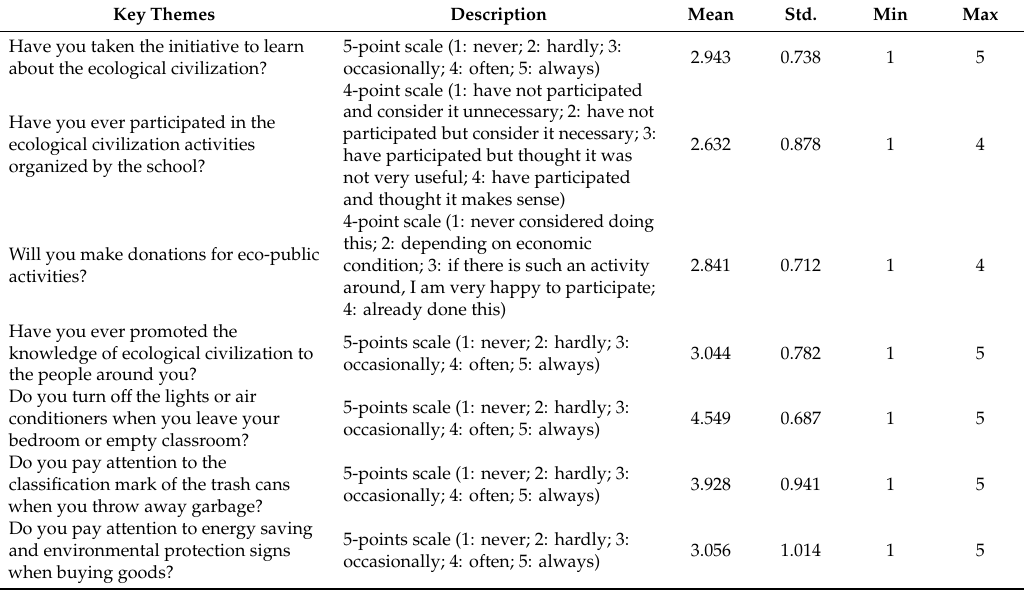
Table 1. Measuring Pro-environmental